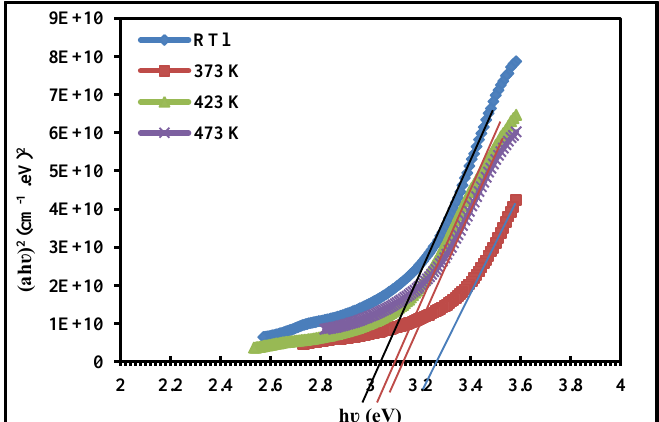
Fig.6: (αhʋ) 2 versus photon energy of incident radiation for as-deposited and annealed blend NiPcTs/Alq thin films 3